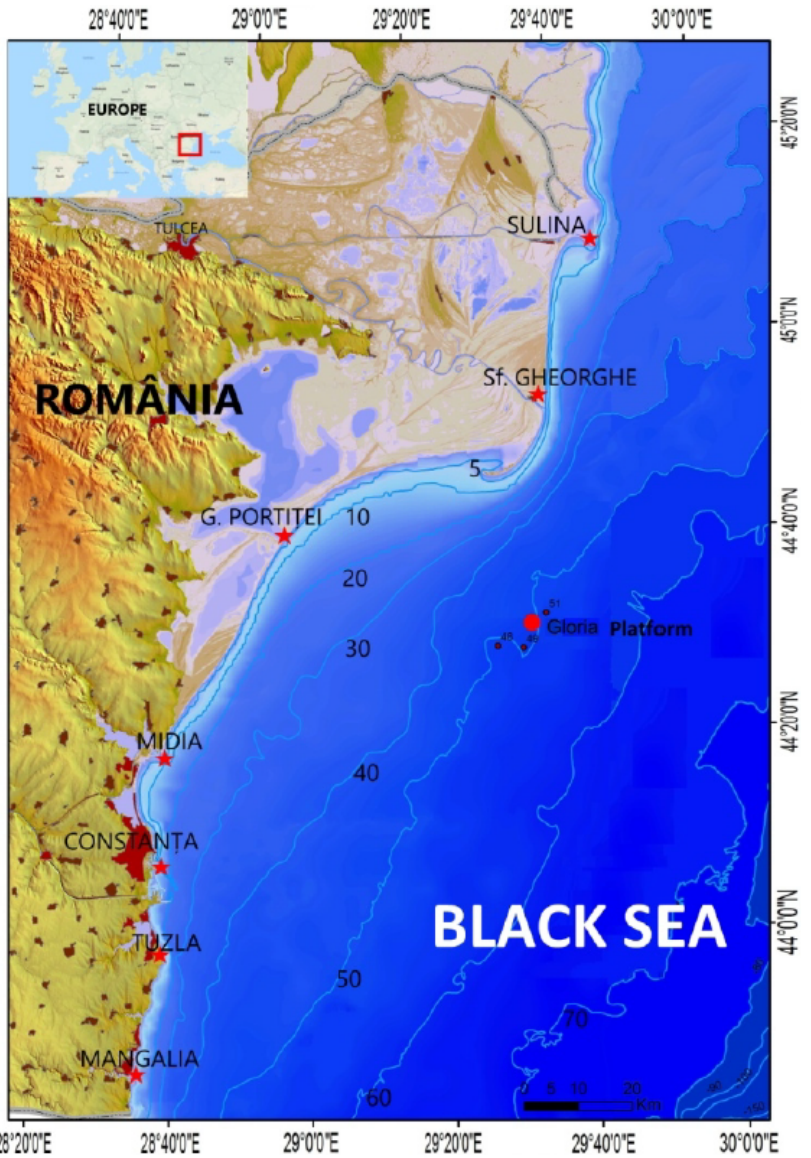
Figure 2. Location of weather stations on the Romanian Black Sea coast [39].